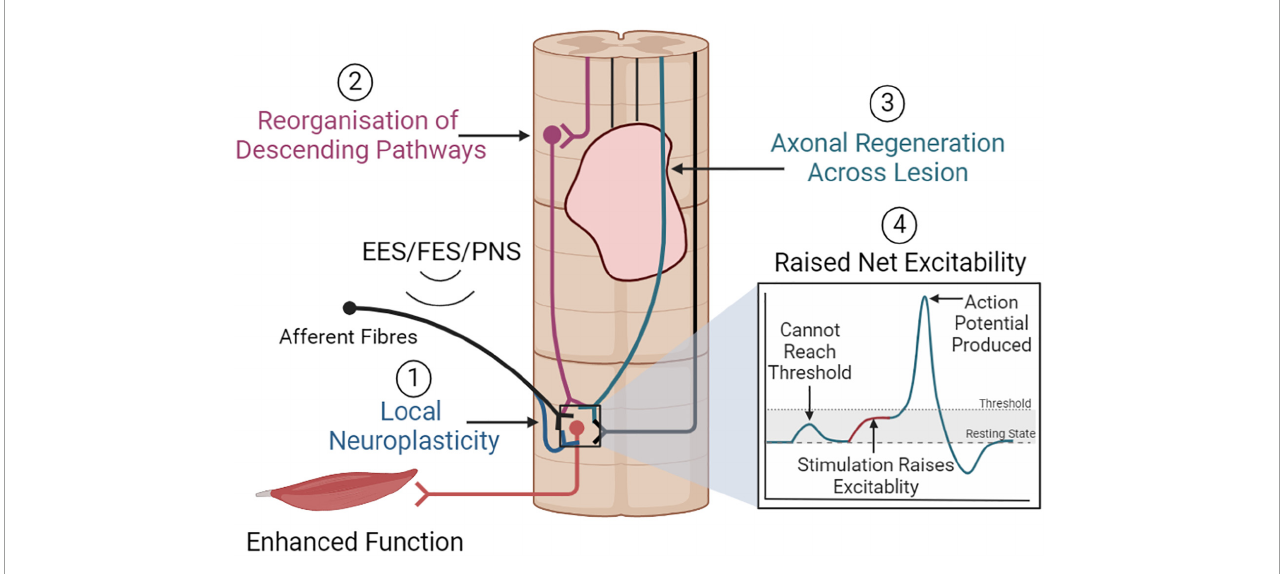
FIGURE5 Overview of neuroplastic mechanisms that may promote functional improvements. (1) Electrical stimulation may promote local neuroplasticity, strengthening motoneuron activation from afferent or descending inputs. (2) Stimulation may also promote the reorganization of descending pathways, or (3) promote axonal regeneration, which together could facilitate greater supraspinal control. (4) Stimulation may raise net spinal cord excitability, allowing the sub-lesioned circuitry to respond to weak residual supraspinal inputs and immediately restore